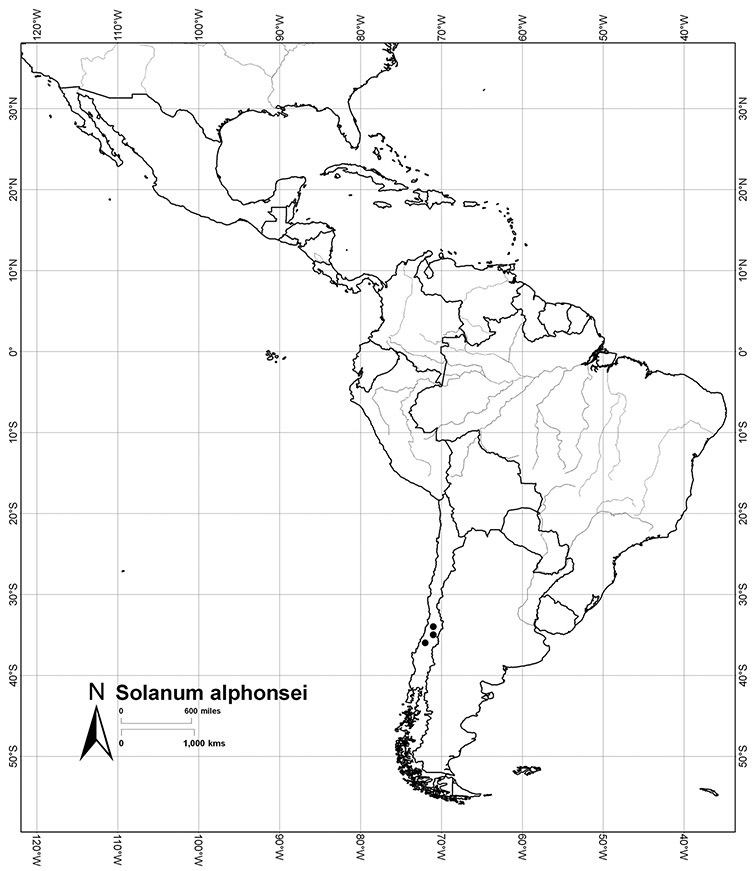
Distribution of Solanum alphonsei Dunal.